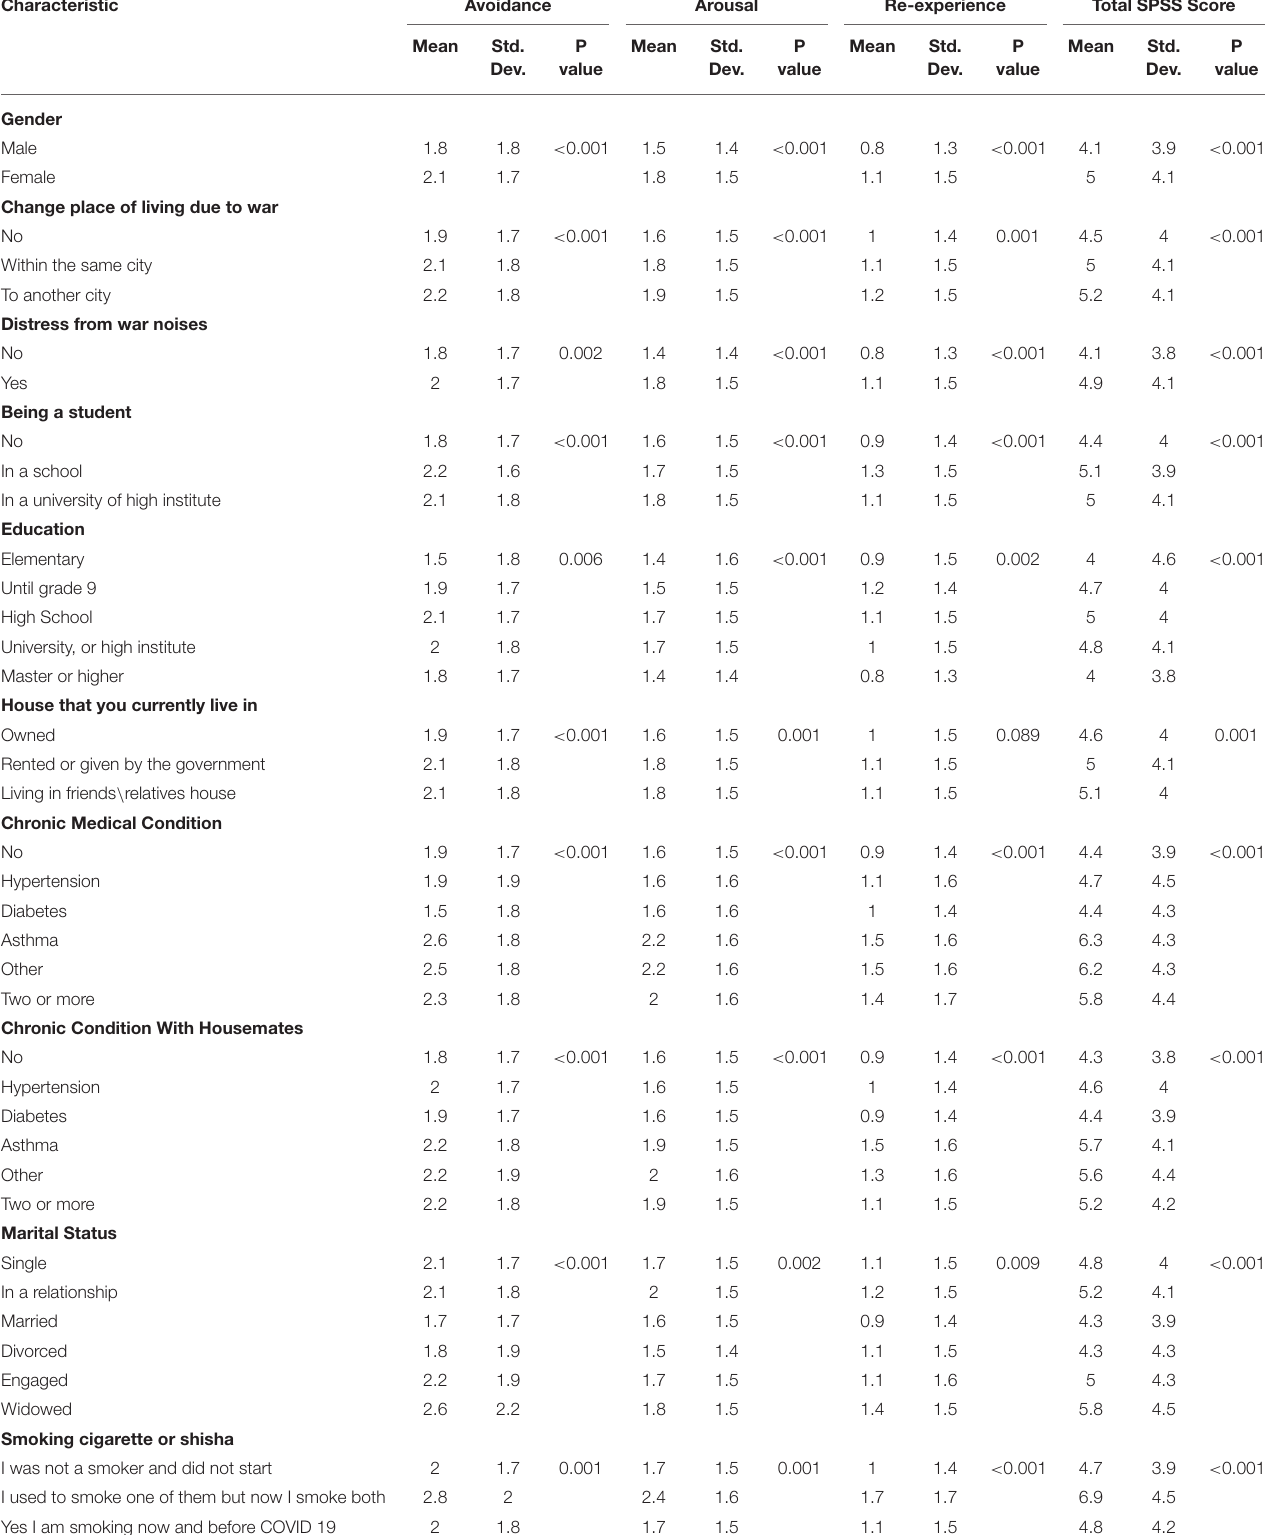
TABLE 3 | SPTSS items and total mean scores and correlations with COVID-19 and war variables along with other variables. Characteristic Avoidance Arousal Re-experience Total SPSS Score